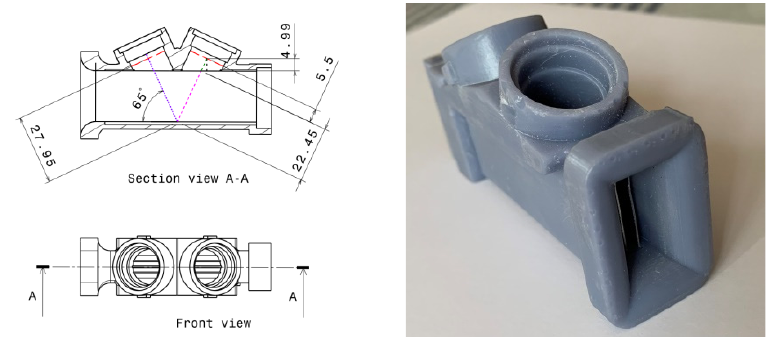
Figure 6. Designed and manufactured V2 pipe.